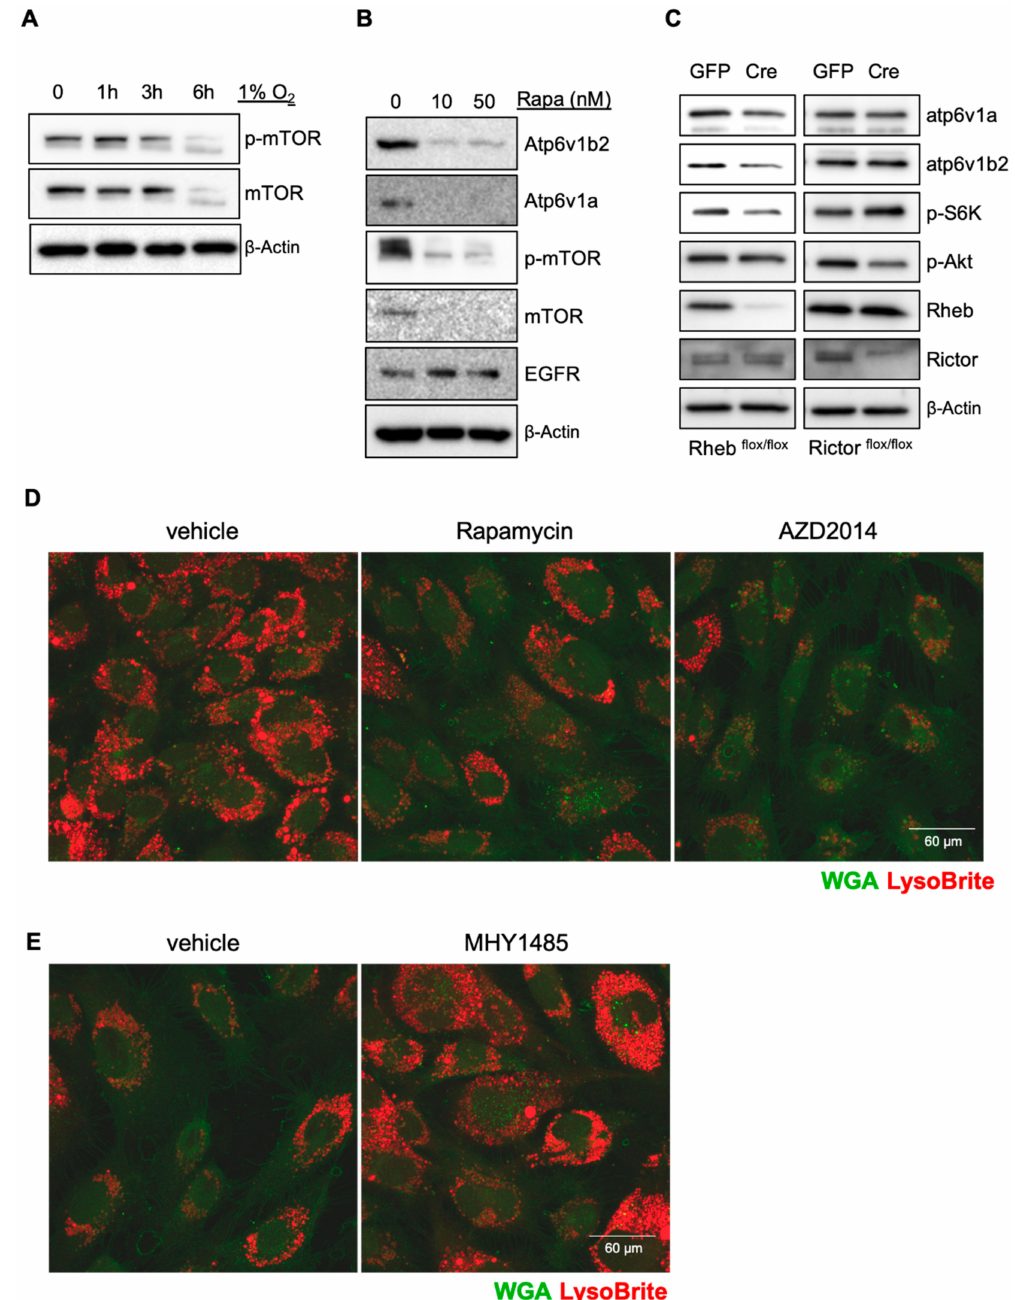
Figure 2. Hypoxia suppresses lysosomal acidification through mTORc1. HUVECs were incubated in 1% O 2 for the indicated times, and phospho- and total mTOR levels were detected from cell lysates ( A ). HUVECs were treated with 10 or 50 nM of rapamycin overnight. Cell lysates were subjected to Western blot ( B ). Lung endothelial cells were isolated from RHEB - or RICTOR -floxed mice followed by infection with GFP or Cre expressing adenoviral vectors for 24 h, followed by Western blot ( C ). HUVECs were incubated in the presence of LysoBrite-NIR in the presence or absence of 10 nM of rapamycin or AZD2014 to block mTORc1( D ), or in the presence or absence of 2 µ M of MHY1485 to activate mTORc1( E ), overnight. Wheat germ agglutinin (WGA) was used for counter staining. Images were collected from confocal microscopy. Representative images are shown. Figure S6 shows the raw data for Western blots of Figure